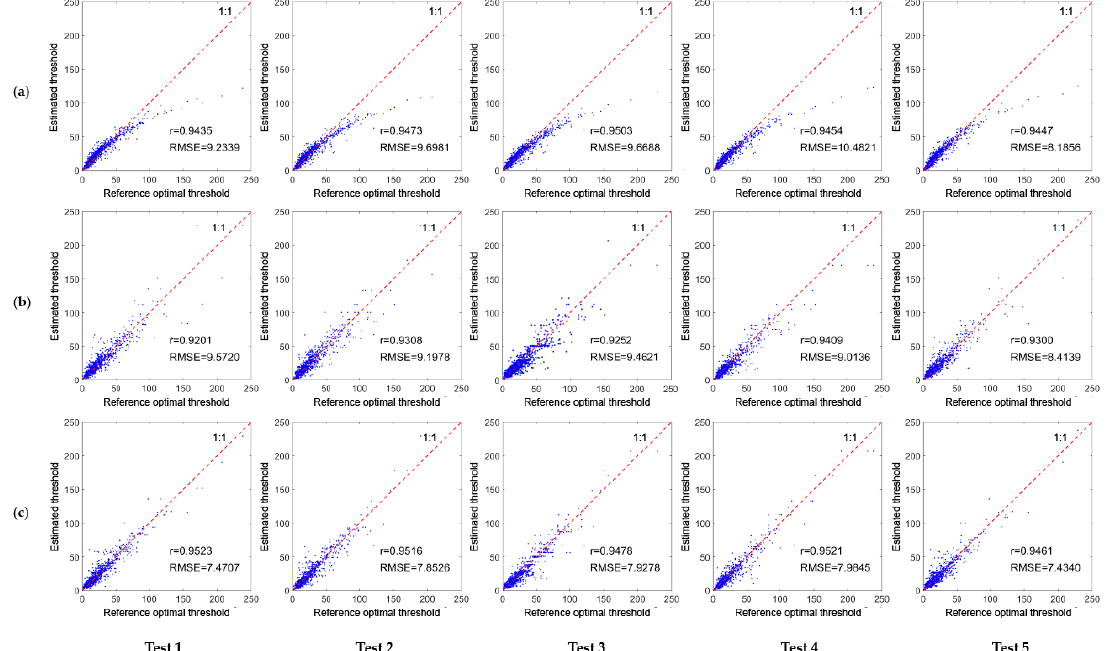
Figure 5. Scatter plots of the estimated thresholds (n · W · cm − 2 · sr − 1 ) against the reference optimal thresholds (n · W · cm − 2 · sr − 1 ) for the validation objects in Tests 1–5 for the logistic regression method ( a ); the proposed method using Euclidean distance (ED) as similarity measure ( b ); the proposed method using Mahalanobis distance (MD) as similarity measure ( c ).